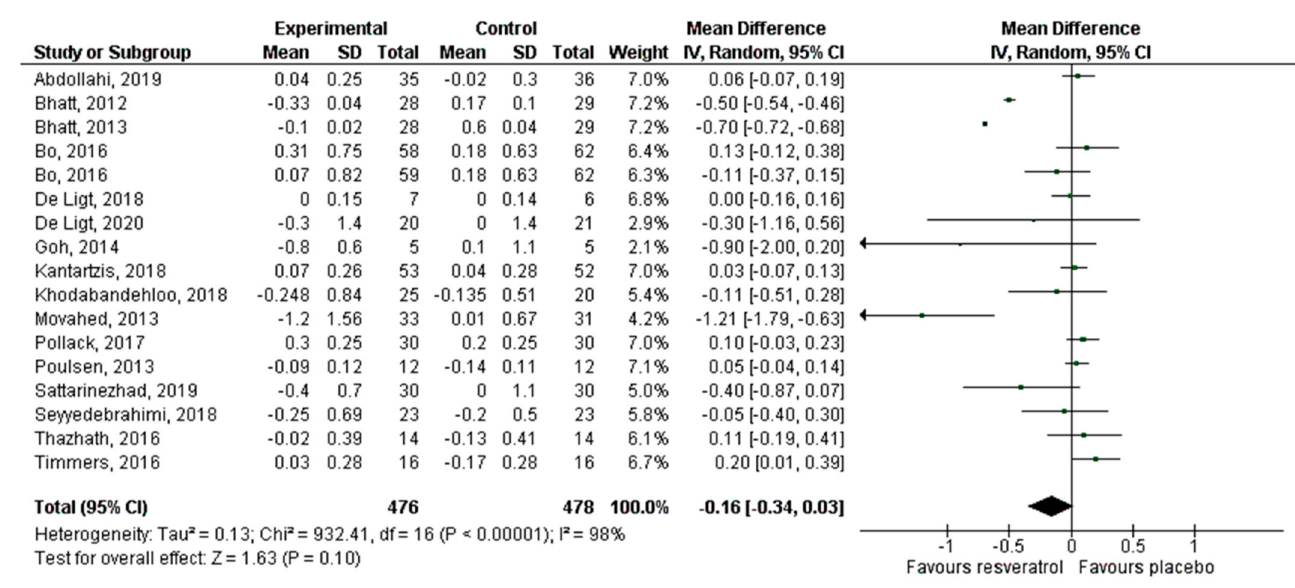
Figure 5. Effect of resveratrol on HbA1c.